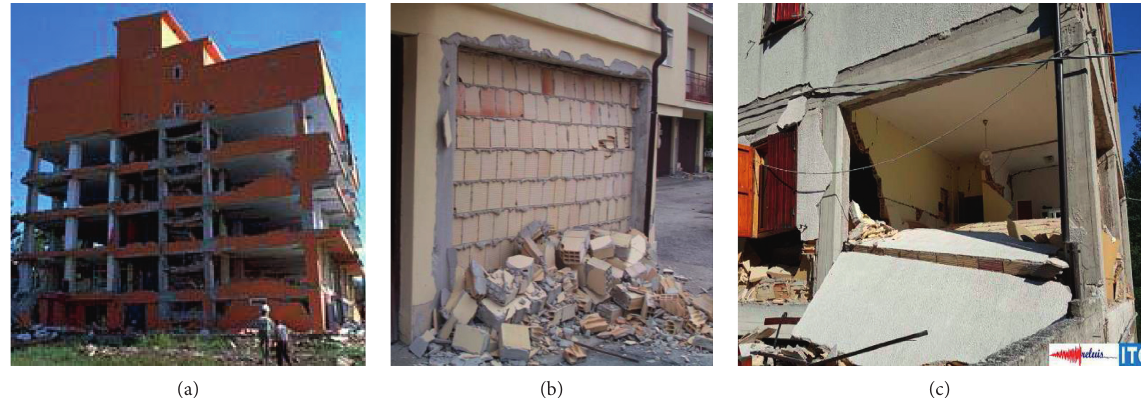
Figure 3: Example of out-of-plane collapses (adapted from [23–25]). (a) Izmit (1999). (b) L’Aquila (2009). (c) Centre Italy (2016).